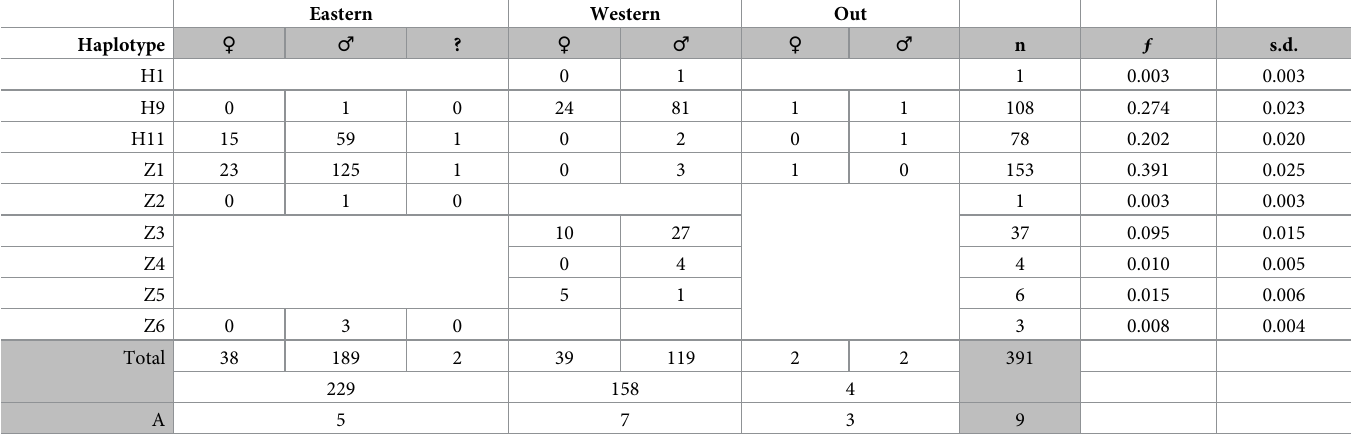
"Out" indicates samples collected outside PAs between sub-populations. n = sample size; for ♂ , ♀ and ? for each area and by area, haplotype and total. A = number of haplotypes. ƒ = frequency. s.d. = standard